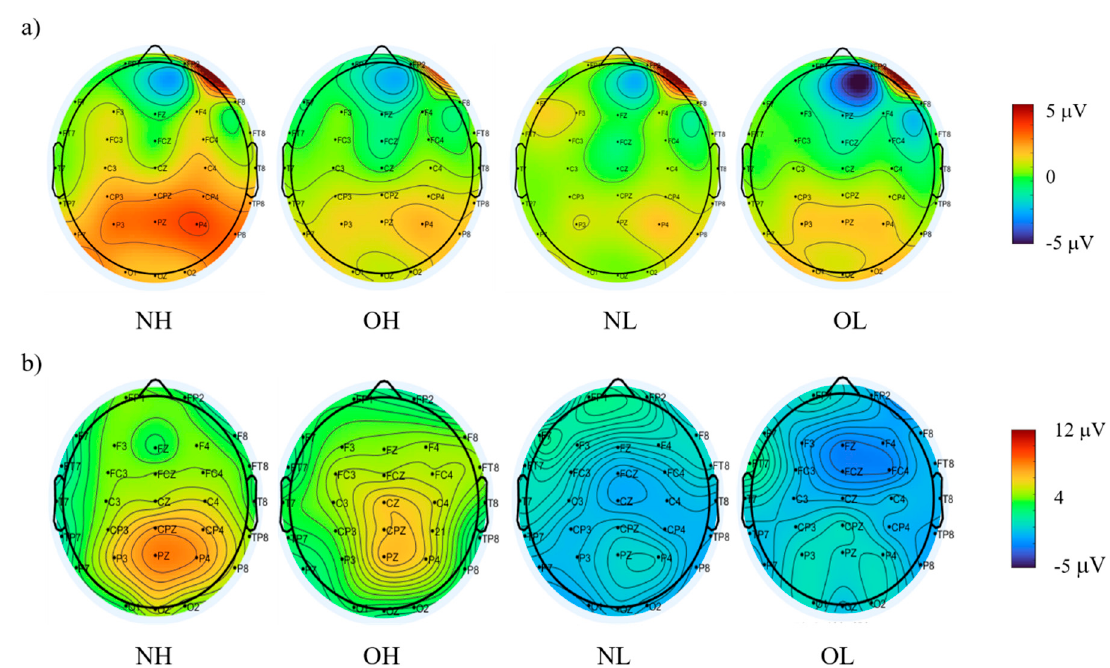
Figure 3. The topographic distributions of the P3 amplitude of ( a ) go- and ( b ) stop-trials across four groups. NH = High CRF with normal weight; OH = high CRF with obesity; NL = low CRF with normal weight; and OL = low CRF with obesity.